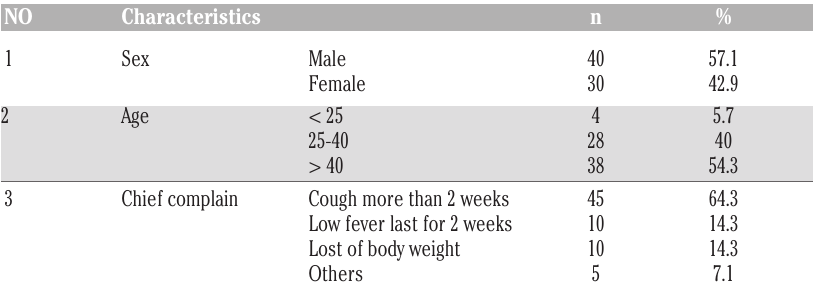
Table 1. The subject’s characteristics whose sputum were used in this study (n =70), both of them were processing with ZN only and ZN added bleach. NO Characteristics